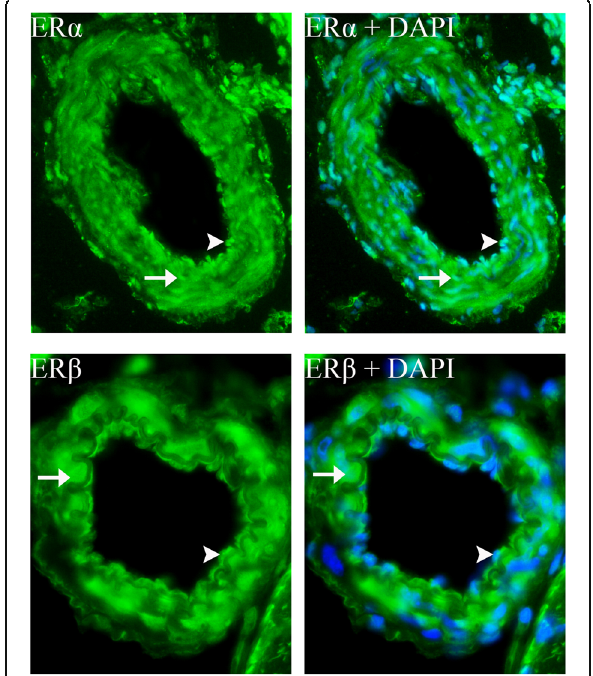
Fig. 9 ER α and ER β distribution in cerebral arteries. ER α and ER β immunohistochemistry of cerebral arteries revealed that both ER α and ER β expression was found in the smooth muscle cells (arrow) and the endothelial cells